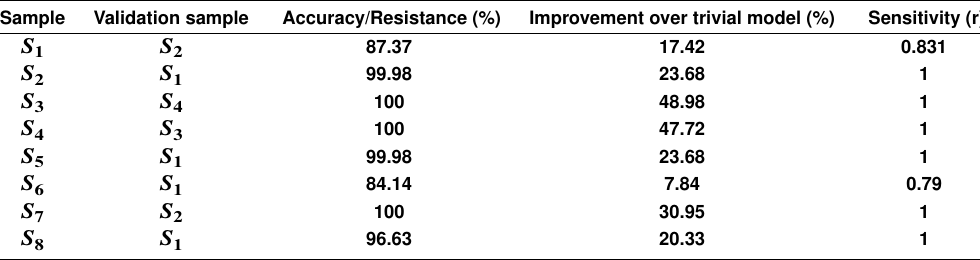
Table 7. Results over validation sets of sample datasets S i .